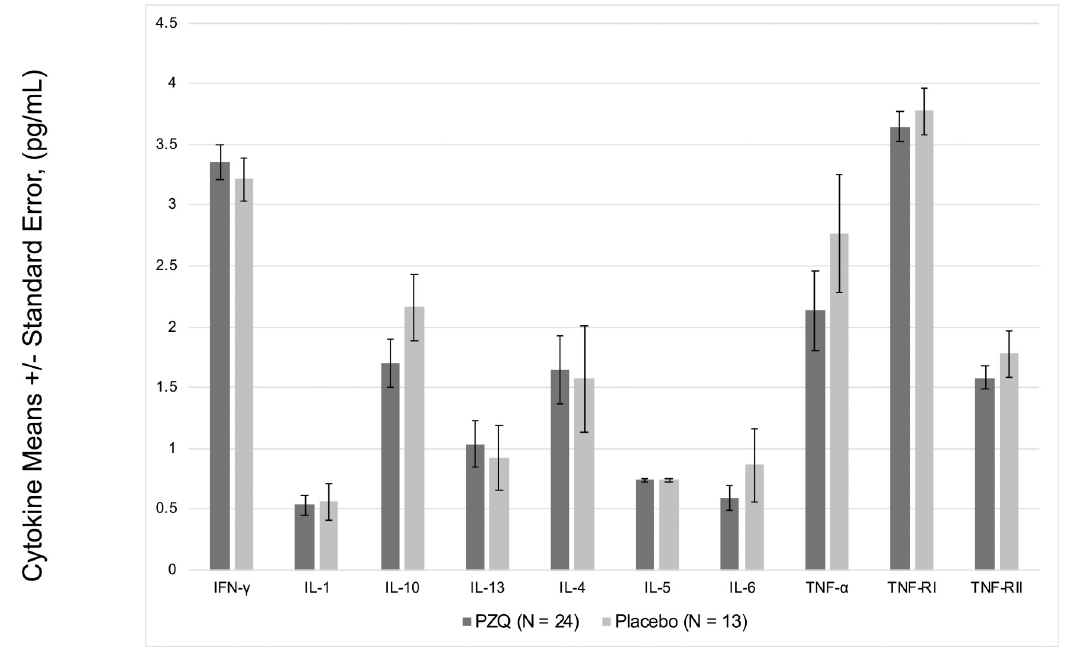
Fig 4. Serum cytokines among children infected with S. japonicum, N = 37. Values are natural log-transformed.